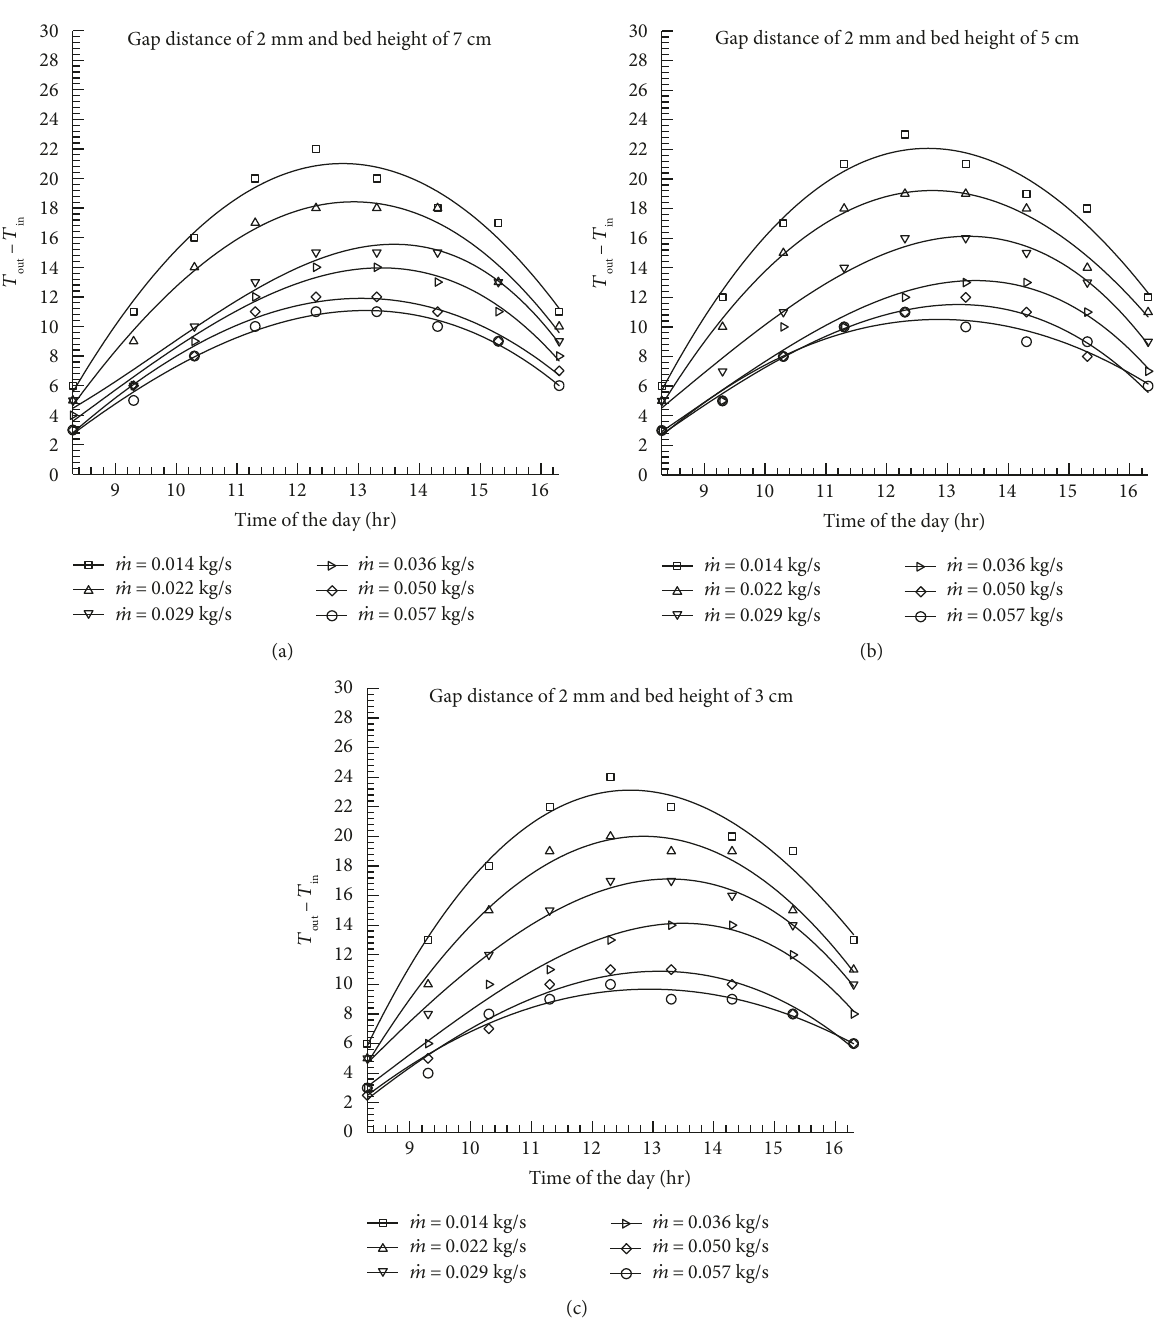
− T out in ) versus time at a gap distance of 2 mm for di